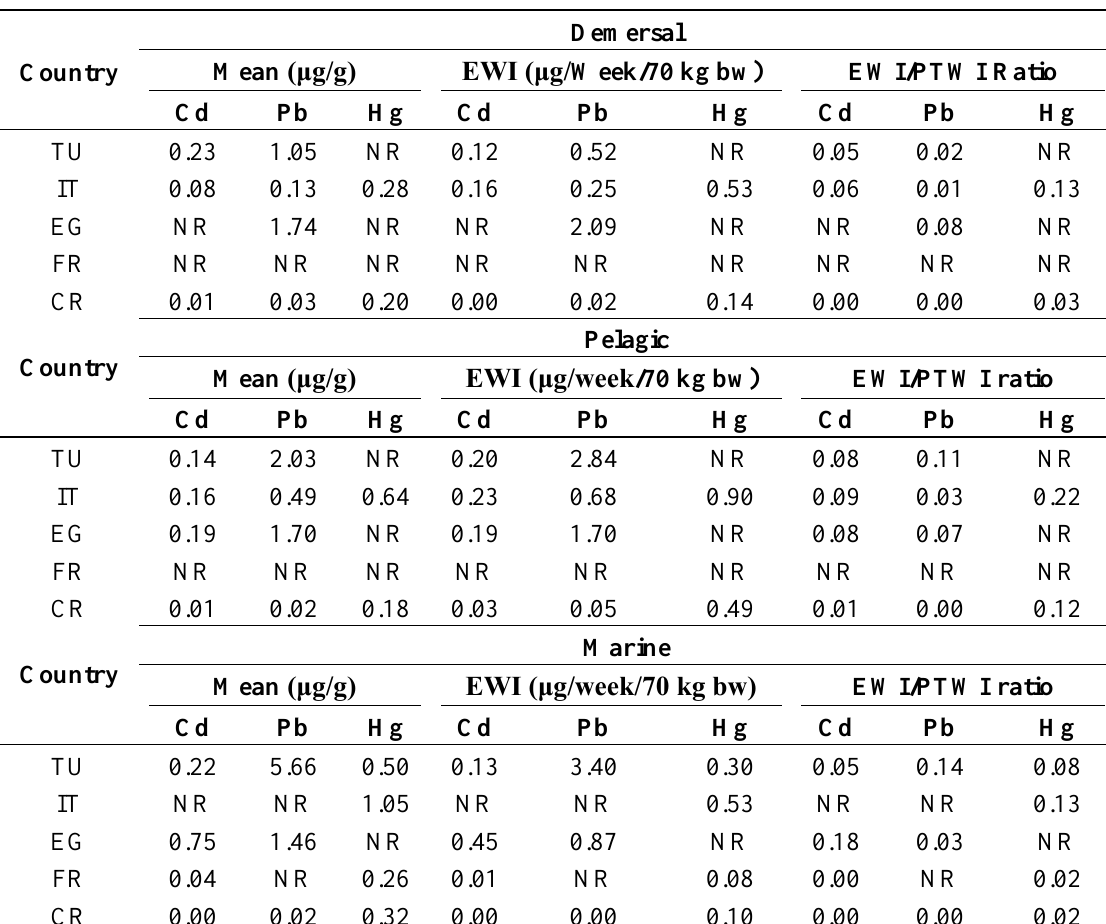
Table 4. EWI (μg/week/70 kg bw) and EWI/PTWI ratio of metals in demersal, pelagic and marine fish per country (TU: Turkey, IT: Italy, EG: Egypt, FR: France, CR: Croatia). Country